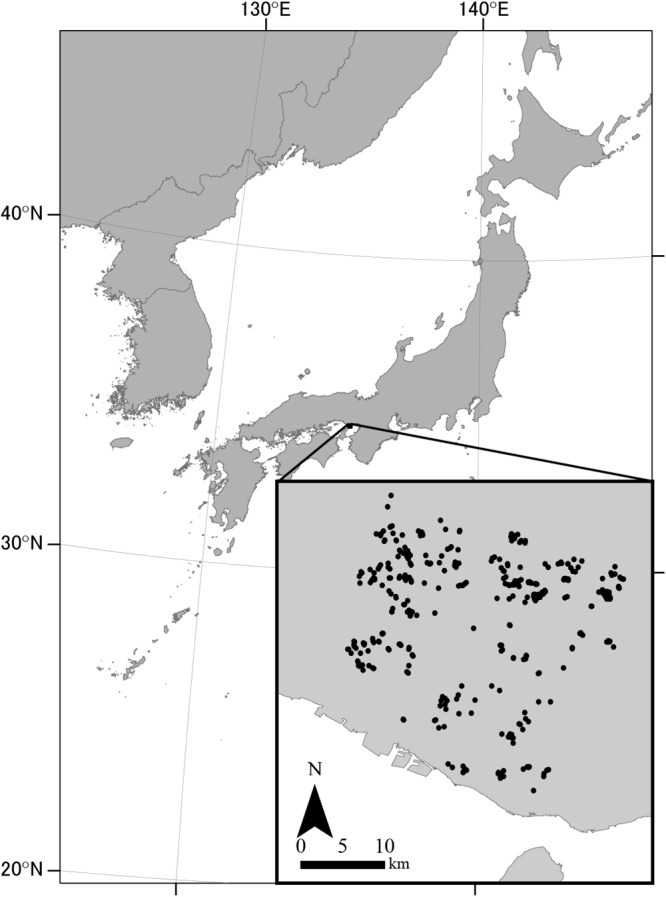
Study area in Hyogo Prefecture, Japan. Dots represent survey ponds.